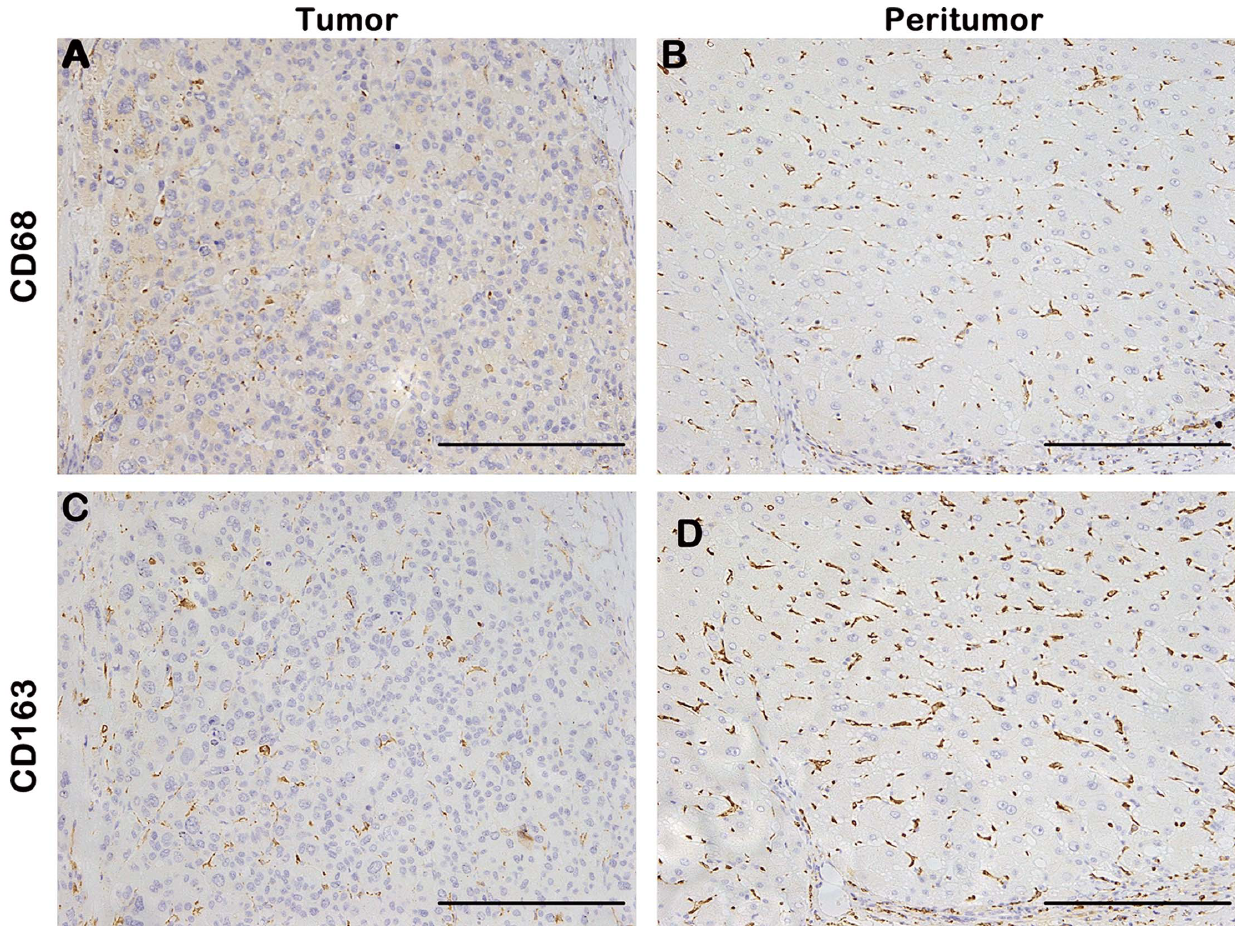
Figure 1. Representative immunostaining of CD163 and CD68 on consecutive sections of paired tumor tissue and peritumoral liver tissue. The densities of intratumoral CD68 + cells (A) and CD163 + cells (C) were lower in tumor than in corresponding peritumoral liver tissue (B and D). The density of CD163 + cells was higher than that of CD68 + cells in both tumor and in peritumoral liver tissue. Scale bar, 200 m m.